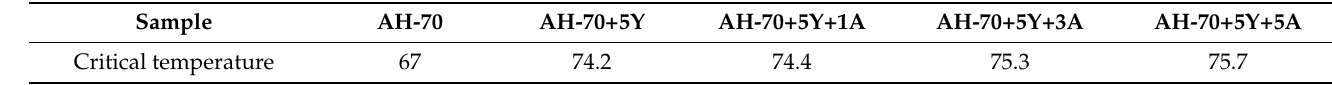
Table 3. Rutting factor critical temperature ( ◦